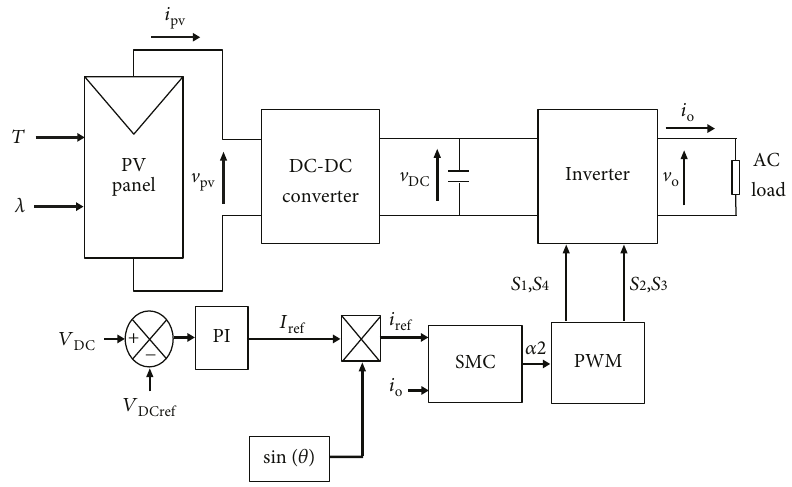
Figure 6: Control strategy followed to elaborate the sliding mode output current controller. Table 1: Speci fi cations of the Mono-Si PV panel SM55 at the STC.